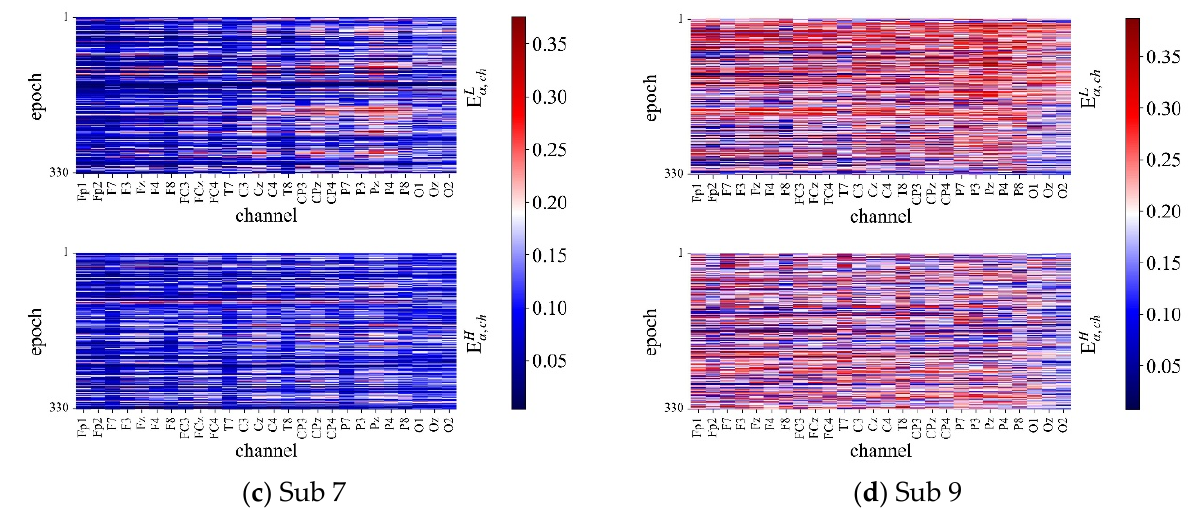
Figure 5. Energy–channel–epoch heatmaps of α rhythm for Subs 1, 3, 7 and 9 in the 2nd experimental period.